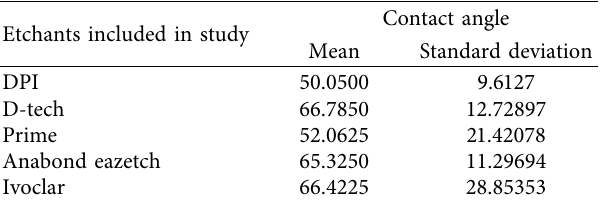
Figure 8: Bar graph indicating the contact angle of the samples in each group. Table 1: Mean and standard deviation of the contact angle for each group. DPI has the least contact angle followed by Prime, while Ivoclar had the highest.